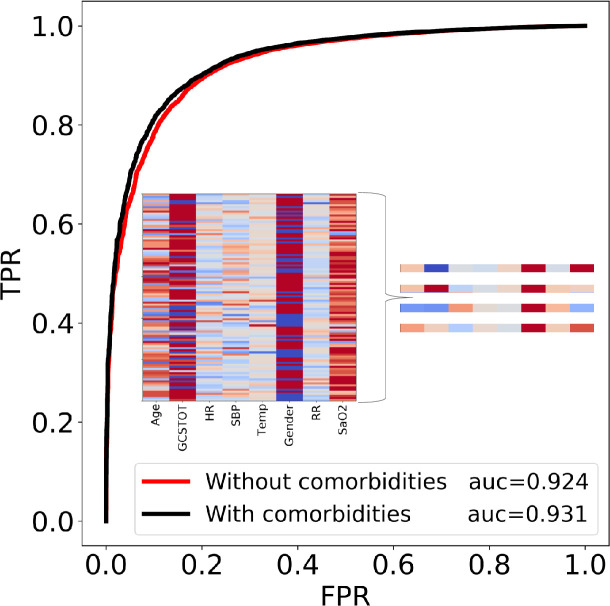
The receiver operating characteristic curves (ROC) for 2 different cases.The true positive rate (TPR) is plotted on the y-axis and the false positive rate (FPR) is plotted on the x-axis for classification thresholds between 0 and 1. In the red curve, only 8 easily measurable vital signs or scores were included in the prediction while the black curve included these and the comorbidities. A full list of features in each case can be found in S1 Table. All results are reported using the second case because the required inputs can be measured rapidly, while knowledge of the comorbidities of a patient is less likely. The heat map in the insert plots the 8 feature values of 100 randomly selected patients, illustrating the high dimensionality of the problem. While no obvious pattern can be seen by humans in the heat map, the algorithm is able to find and quantify one. 4 zoomed-in examples are provided for clarity. Note that each column is normalized by its own feature value range.